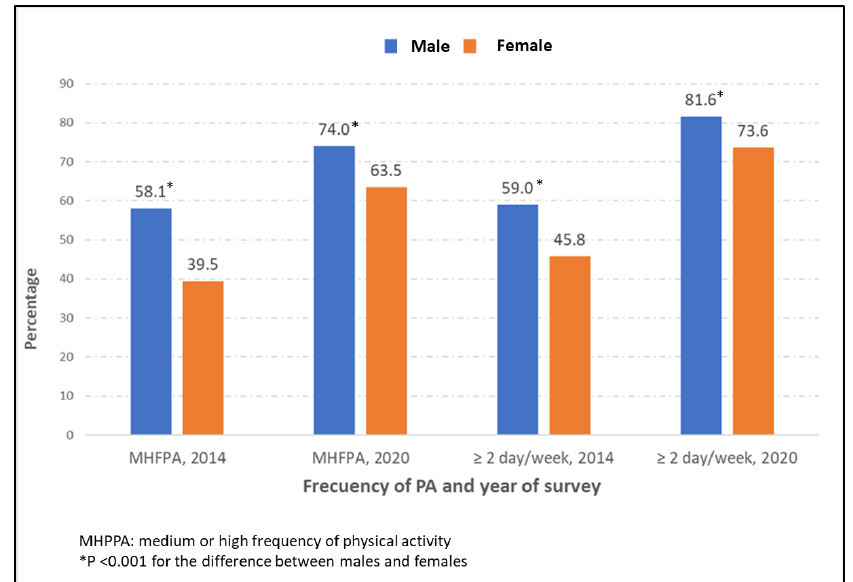
Figure 1. Frequency of medium or high frequency of physical activity (PA) and number of days of PA per week ≥2 according to gender among people with self-reported diabetes included in the European Health Interviews Surveys for Spain (EHISS) conducted in years 2014 and 2020.